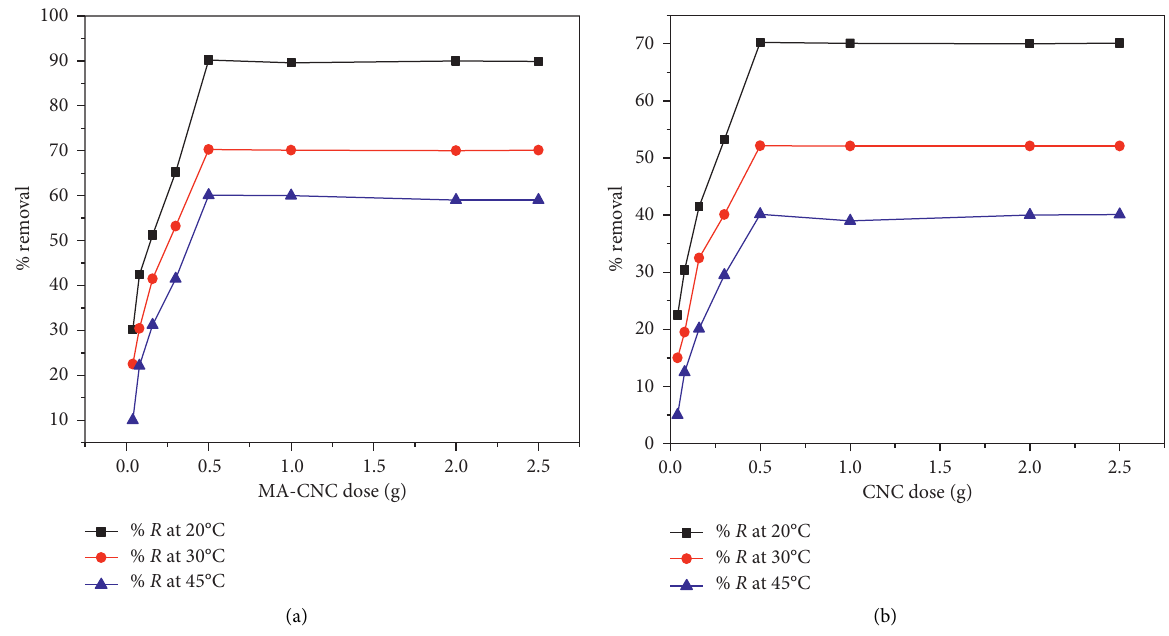
Figure 6: (a, b) Effects of adsorbent dose at different temperatures (20, 30, and 45 ° C) for Cd(II) ions’ remediation using CNC and MA-CNC adsorbents, respectively, at an optimum contact time of 120min, agitation speed of 250rpm, pH of 8, and initial concentration of